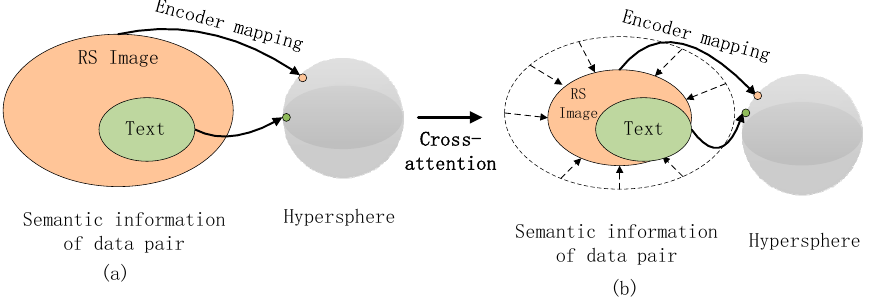
Figure 1. ( a ) Displays a large distance between image and text features over the hypersphere under the interference of redundant information. ( b ) Displays the compression of image information in a specific direction, such that the distance (between image and text features) is shrunk under the cross-attention mechanism.